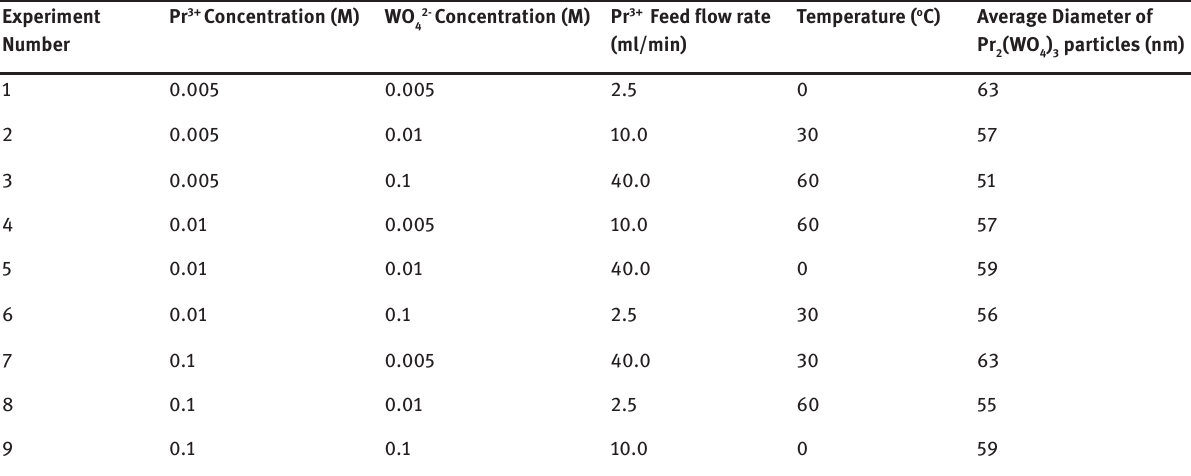
(3 4 ) matrix applied for optimization of synthesis procedure. Table 1: OA 9 Experiment